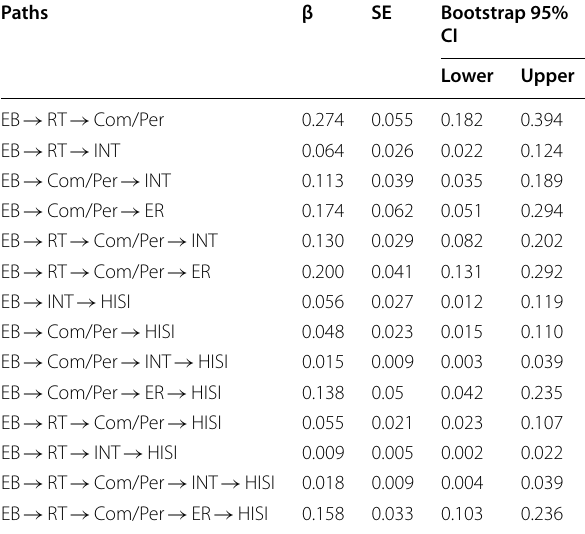
Table 2 Indirect effects of epistemological beliefs, reflective